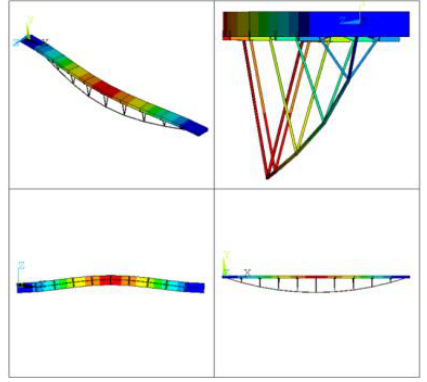
Figure 7. Lateral bending mode ( f s